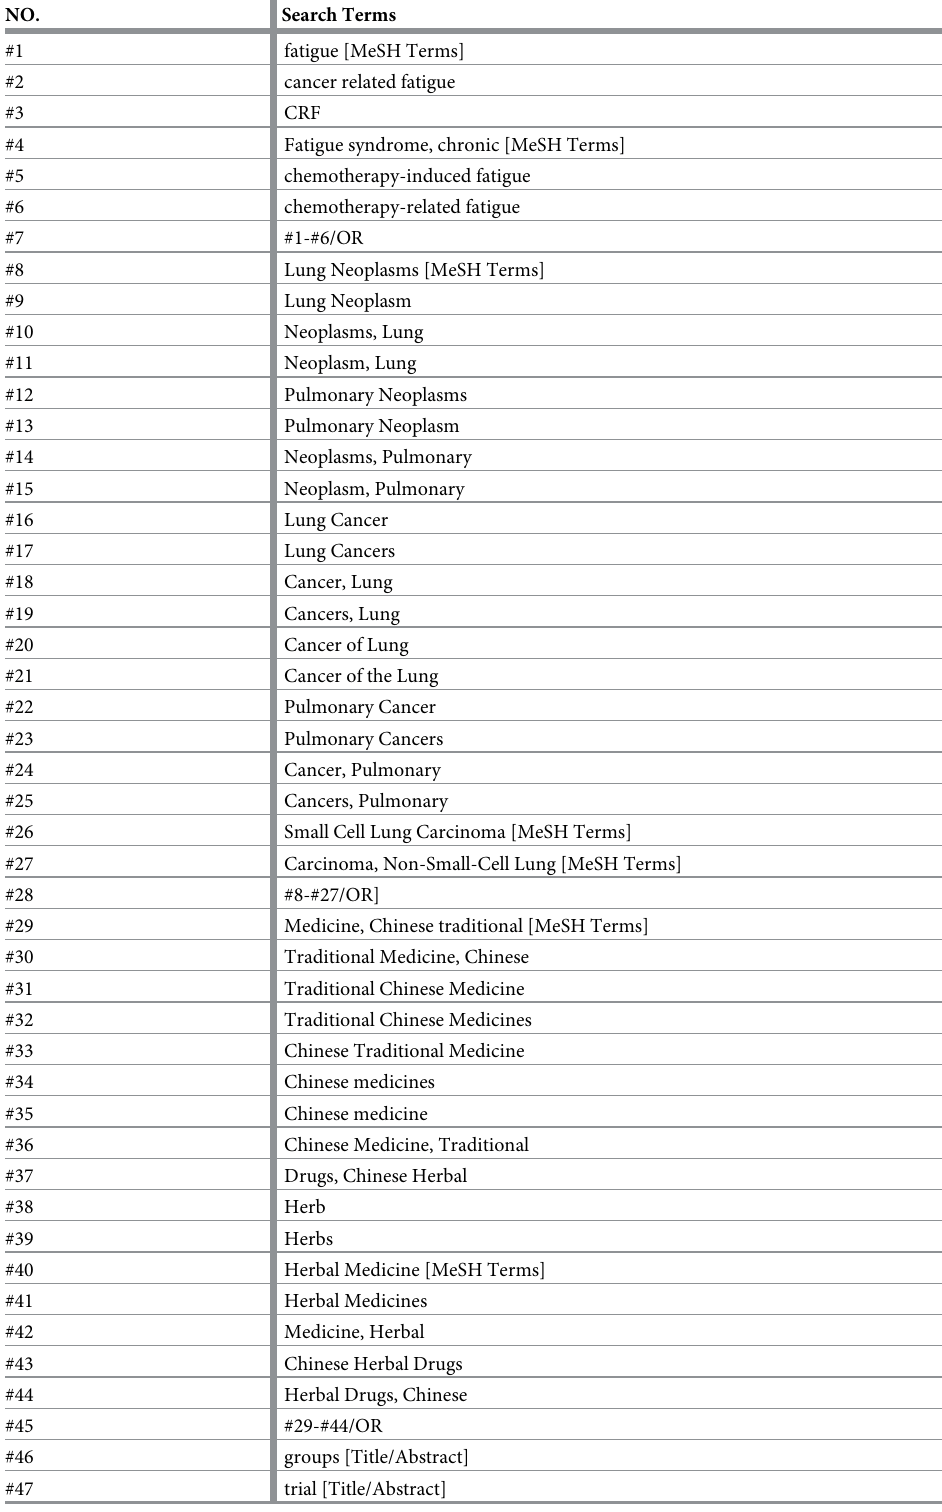
Table 1. Search strategy for